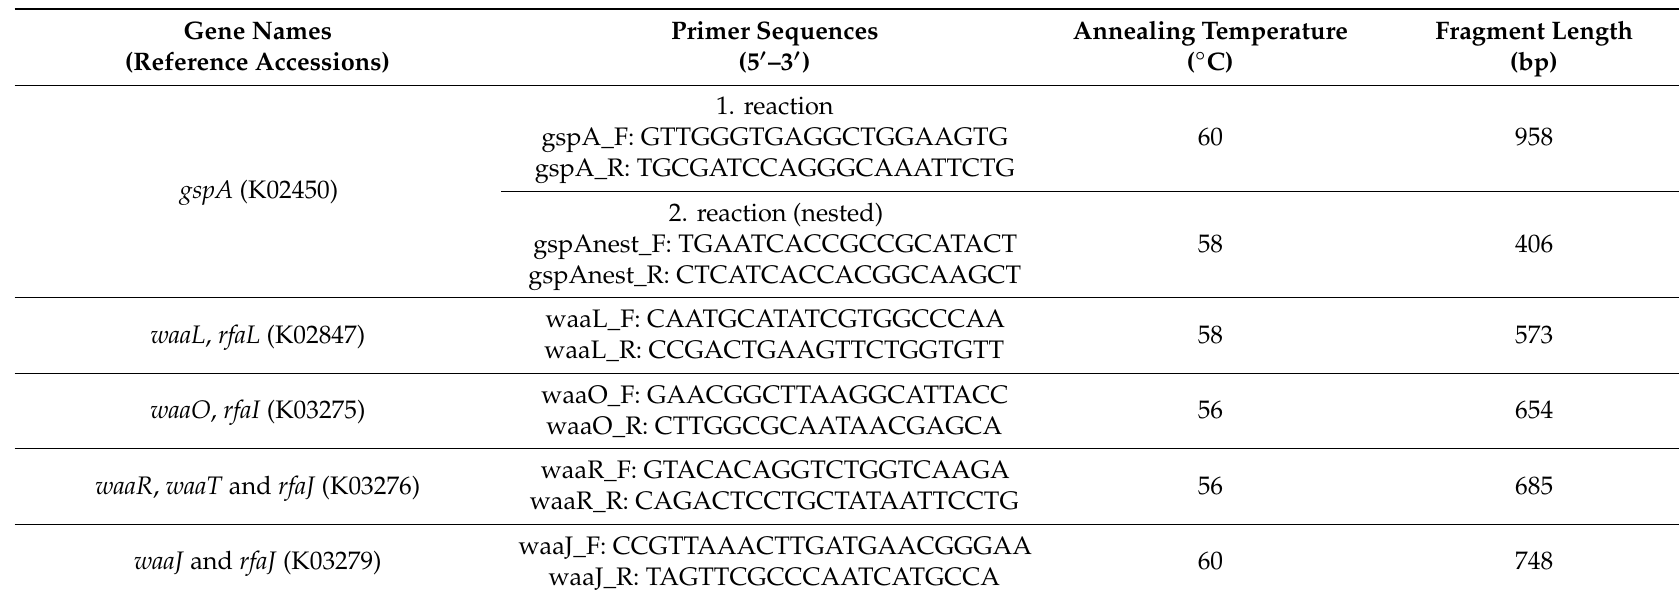
Table 2. Primers and PCR conditions used for amplification of α -1,3-galactosyltransferase genes from midgut bacteria of Ixodes ricinus